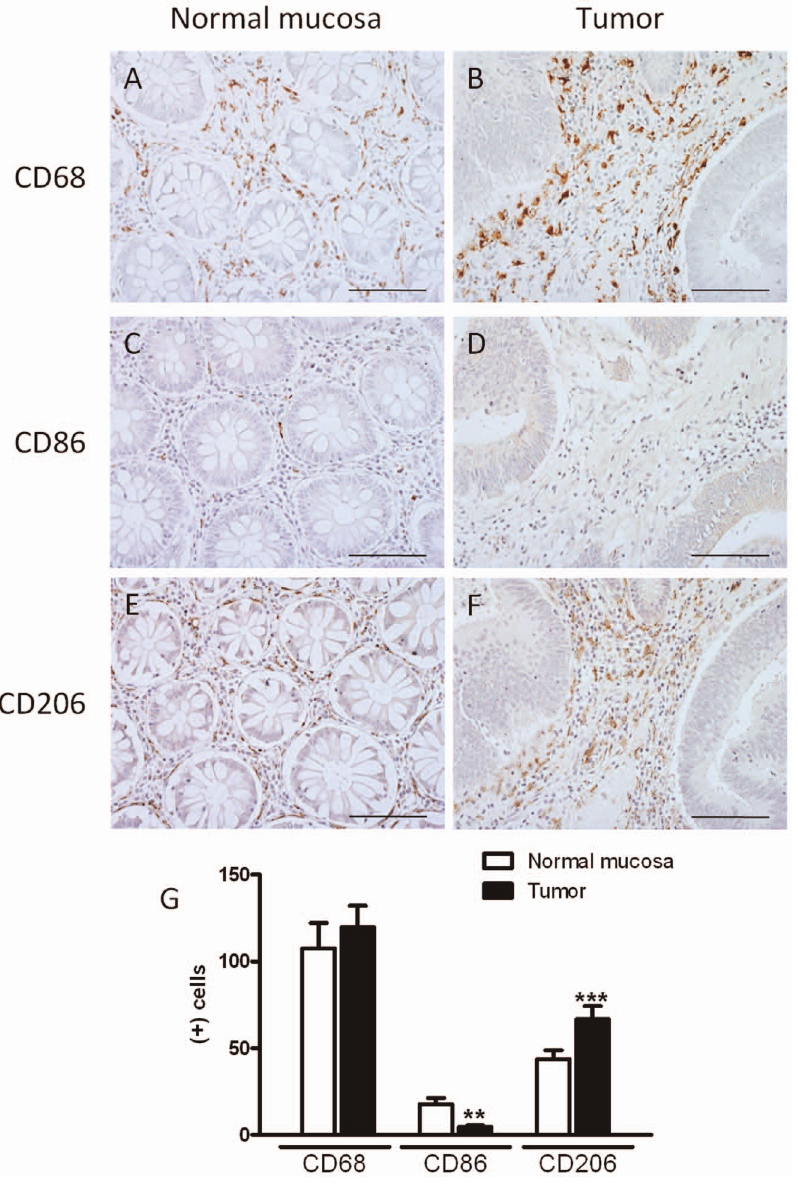
Figure 1. Pattern of macrophage infiltration in colorectal cancer and healthy surrounding tissues. The immunoreactivity to CD68 (MF marker, A–B), CD86 (M1-MF marker, C–D) and CD206 (M2-MF marker, E–F) was analyzed in colorectal cancer (B, D, F) and healthy surrounding mucosa (A, C, E). (G) Quantitative analysis of positive cells for these molecules in a representative area of 0.22 mm 2 (Scale bar =0.2 mm). Bars represent mean 6 SEM (n=21). **P , 0.01 and ***P , 0.001 vs corresponding value in normal mucosa.